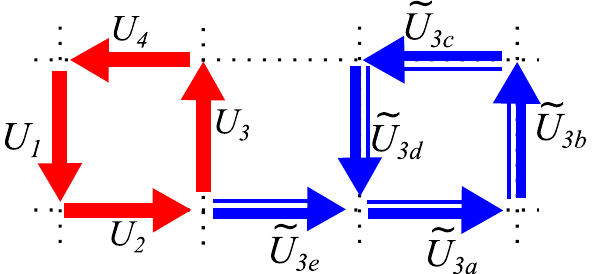
Fig. 4 Another sublattice of the representation given in Fig. 2 with the links labeled while the blue path the group integration gives